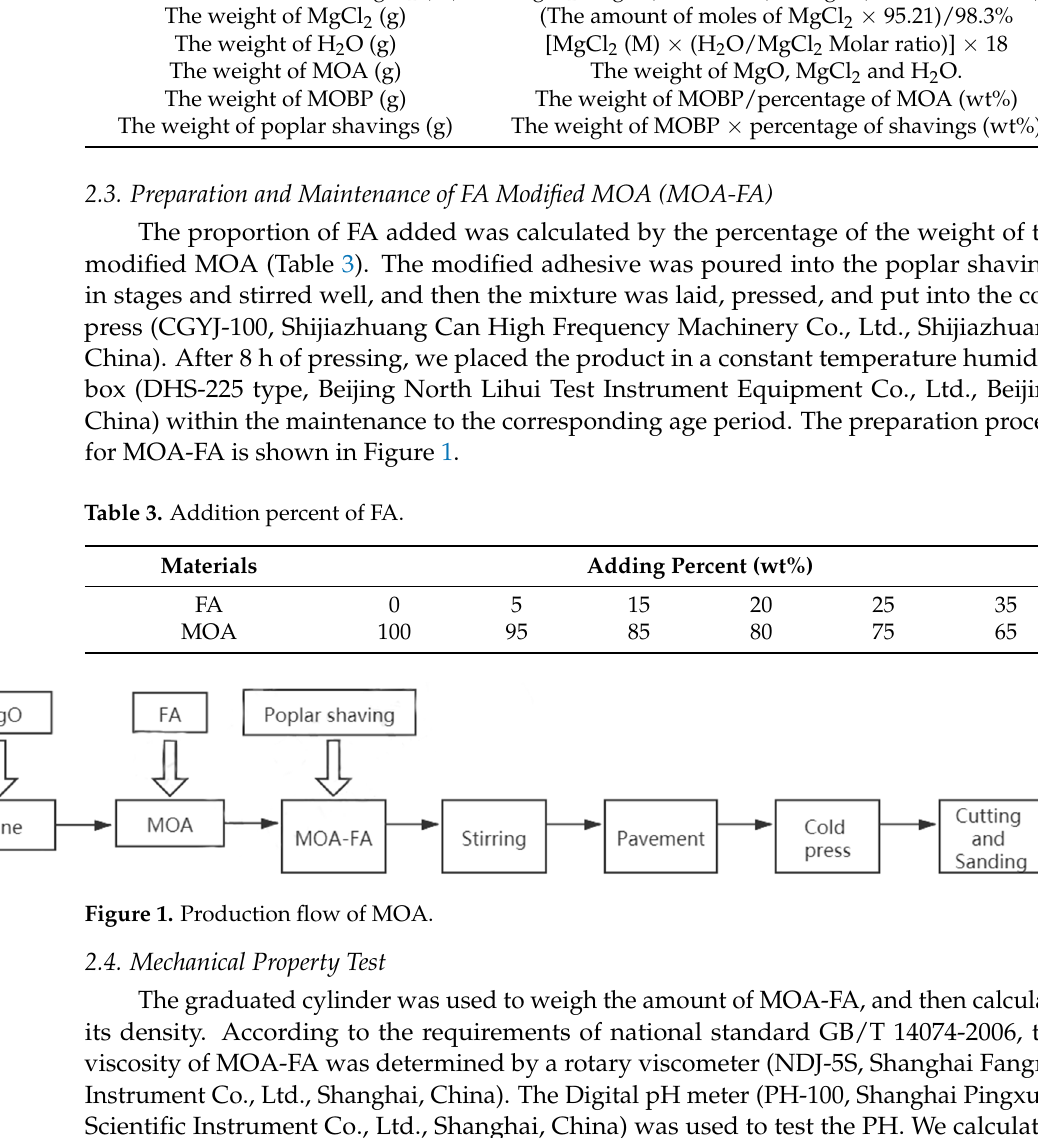
Table 2. Calculating methods of different raw materials.